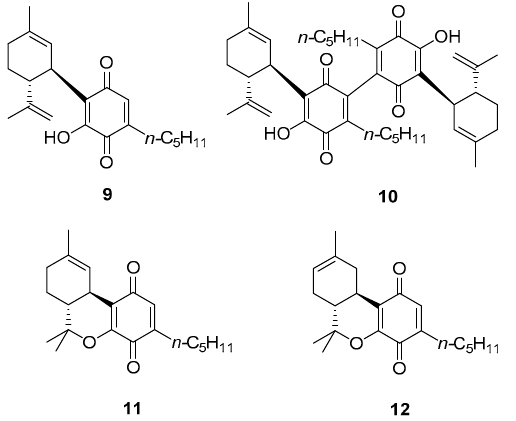
Figure 3. Structure of p -CBDQ (HU-331, 9 ), its dimer ( 10 ), p - Δ 9 -THCQ ( 11 ) and p - Δ 8 -THCQ ( 12 ).